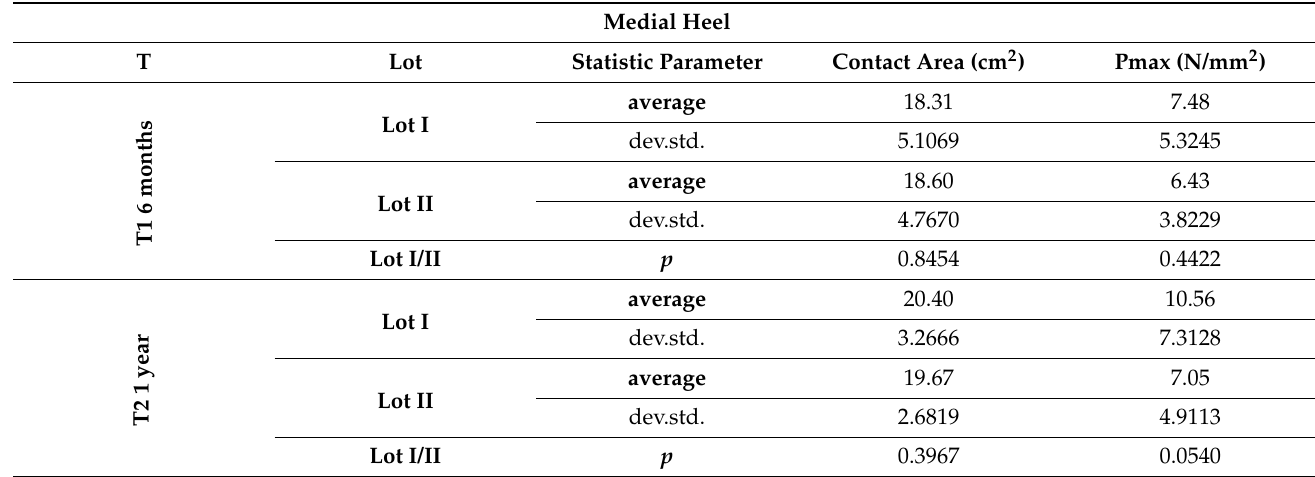
Table 4. Average values for medial heel, 6 months and 1 year.